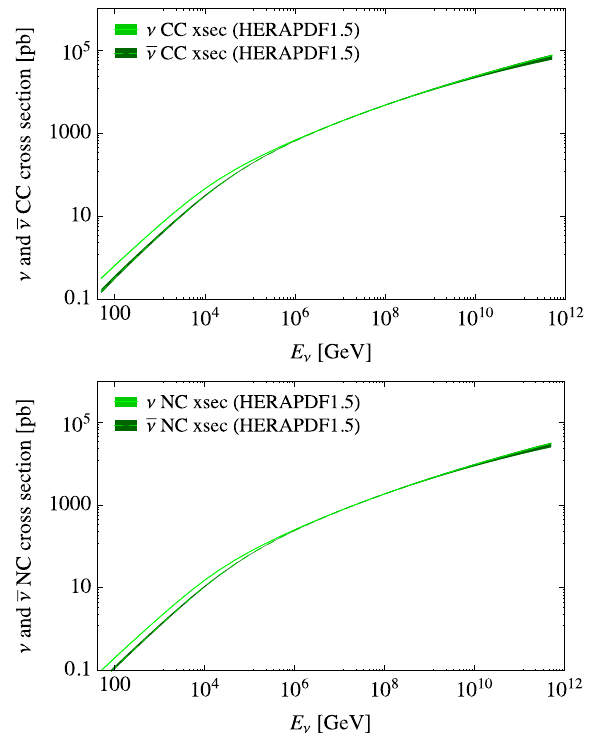
Fig. 12 High-energy charged current (top panel) and neutral current (bottom panel) neutrino and anti-neutrino cross sections based on the ZEUS global PDF fits [94]; the width of the lines indicate the uncer- tainties. Figure from Ref.